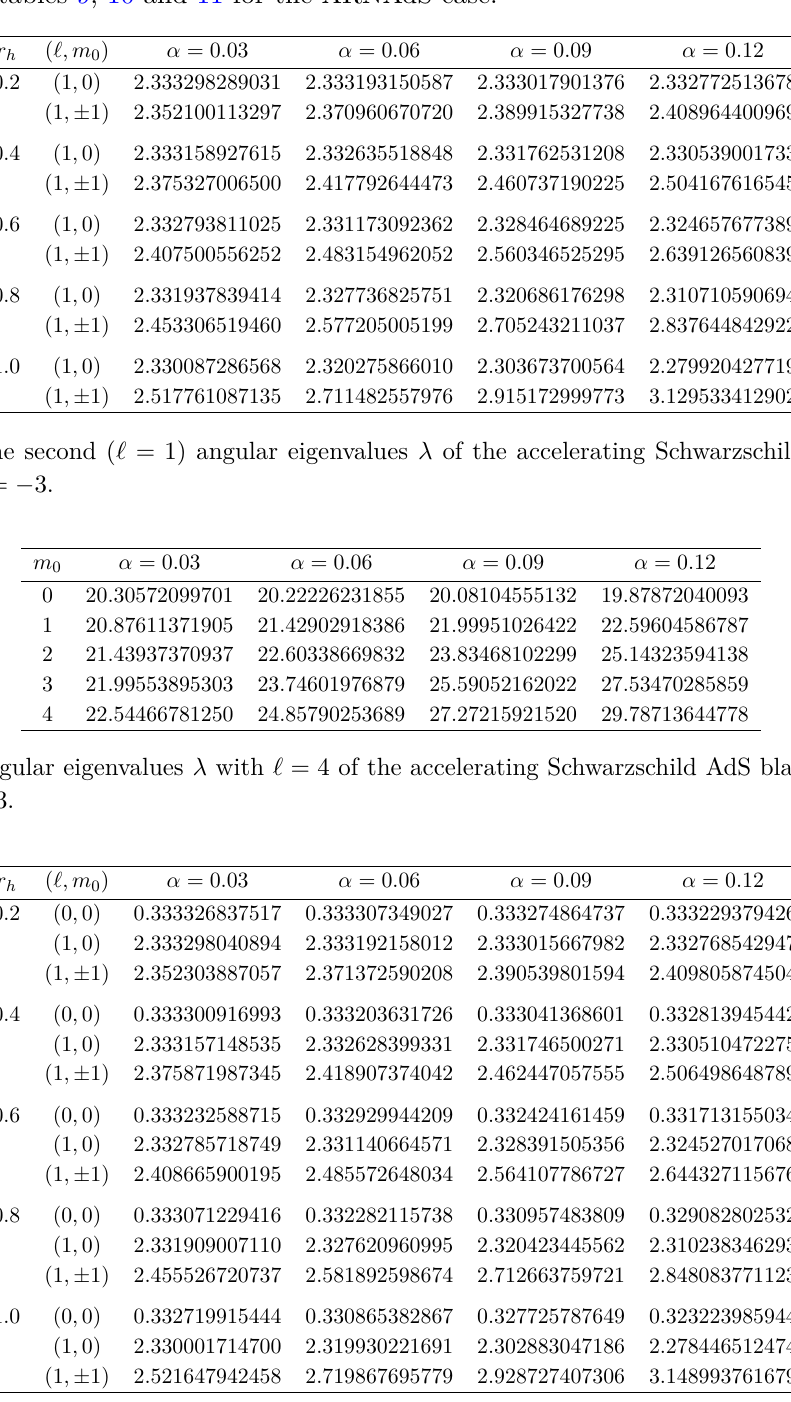
Table 9 . Angular eigenvalues λ of the ARNAdS black hole with Λ = − 3 and Q = 0 . 1